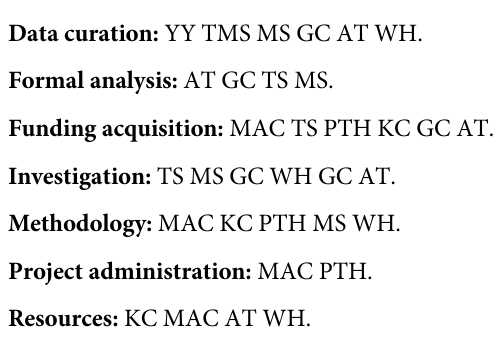
S1 Fig. Optimization of EGFR-NLP assemblies. A , Empty NLPs were assembled with increasing amounts of egg PC at listed ratios followed by separation by Superdex 200 SEC col- umn and typical traces are shown. Empty NLPs elute between 22–26 minutes. B , EGFR-NLPs were assembled with increasing amounts of EGFR at listed ratios followed by separation by Superdex 200 SEC column and typical traces are shown. Empty NLPs elute between 22–26 minutes with EGFR-NLPs eluting earlier at 16–22 minutes. Triton-solubilized EGFR was eluted between 36–38 minutes. C , An empty NLP assembly was separated by Superdex 200 SEC column (top). To obtain a more uniform NLP size, center fractions were collected, con- centrated, and reseperated by SEC column